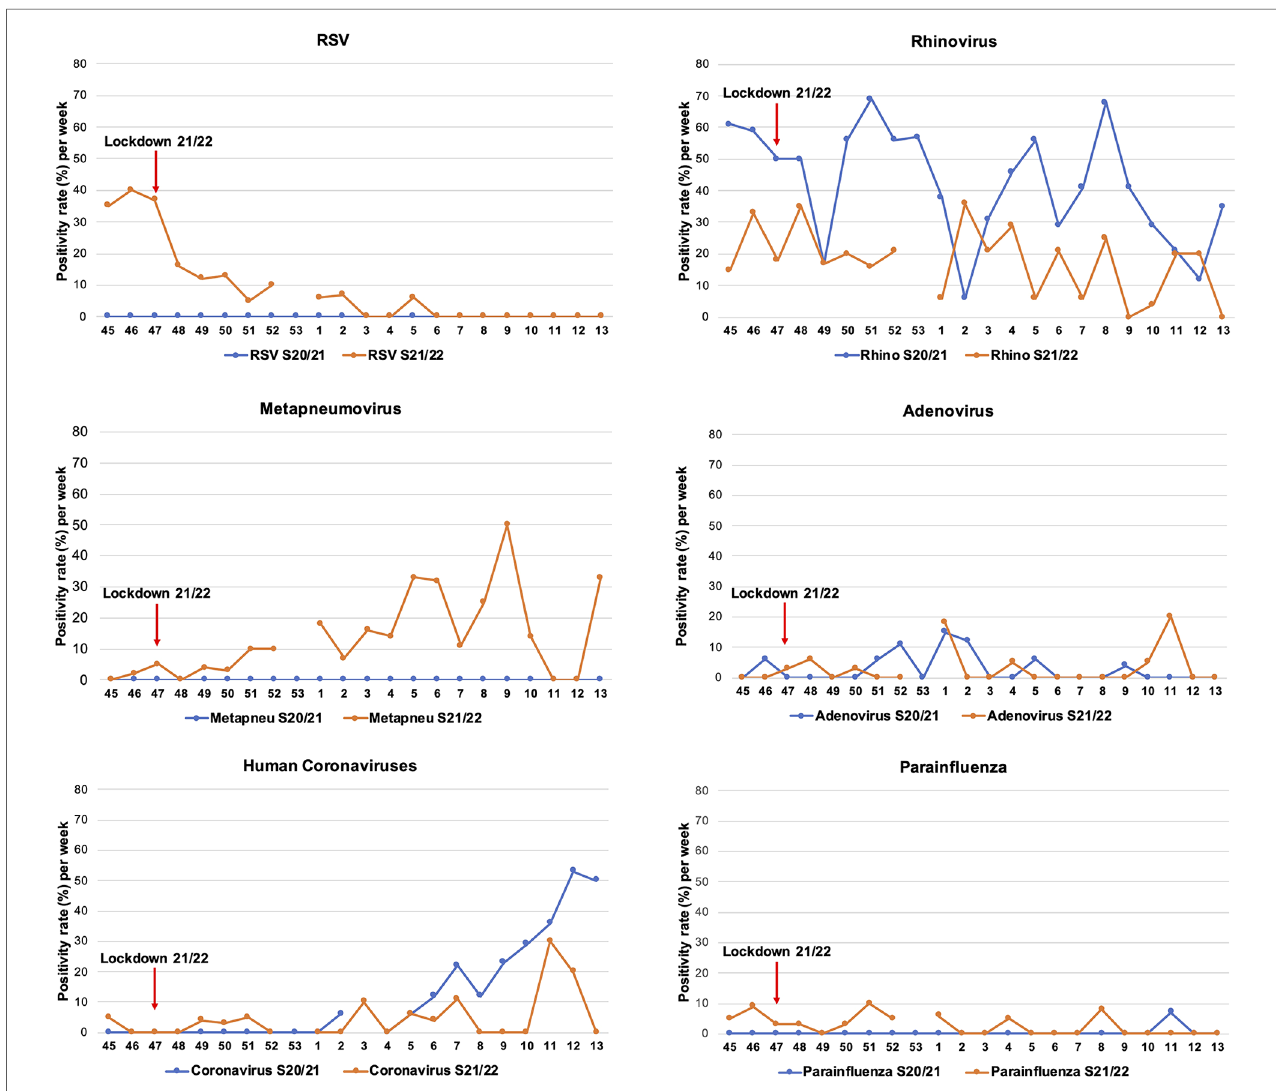
FIGURE 3 Positivity rate of pathogens in both COVID-19 winter seasons. The positivity rate of pathogens in the winter season 2020/2021 (blue lines) and 2021/2022 (orange lines) are presented. The lockdown in the winter season 2021/2022 starting from calendar week 47 is shown (red arrow).